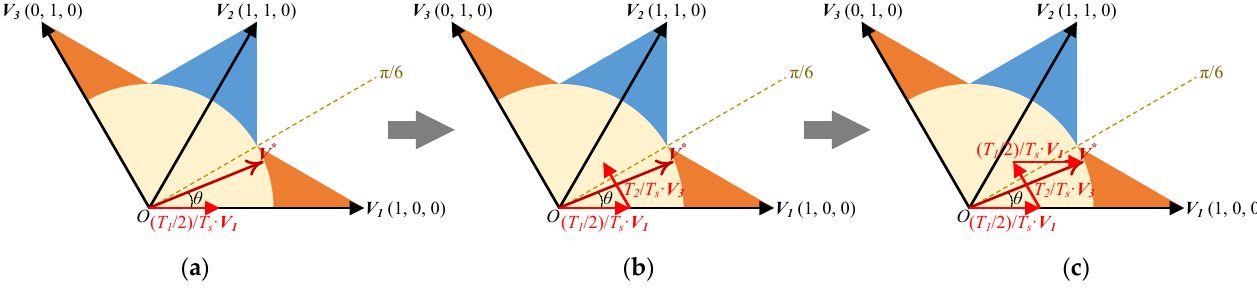
Figure 6. Process of synthesizing reference voltage vector in sector 1: ( a ) During first half of T 1 ; ( b ) During T 2 ; ( c ) During second half of T 1 .